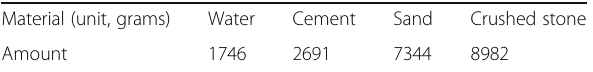
Table 1 Parameters of concrete Material (unit,